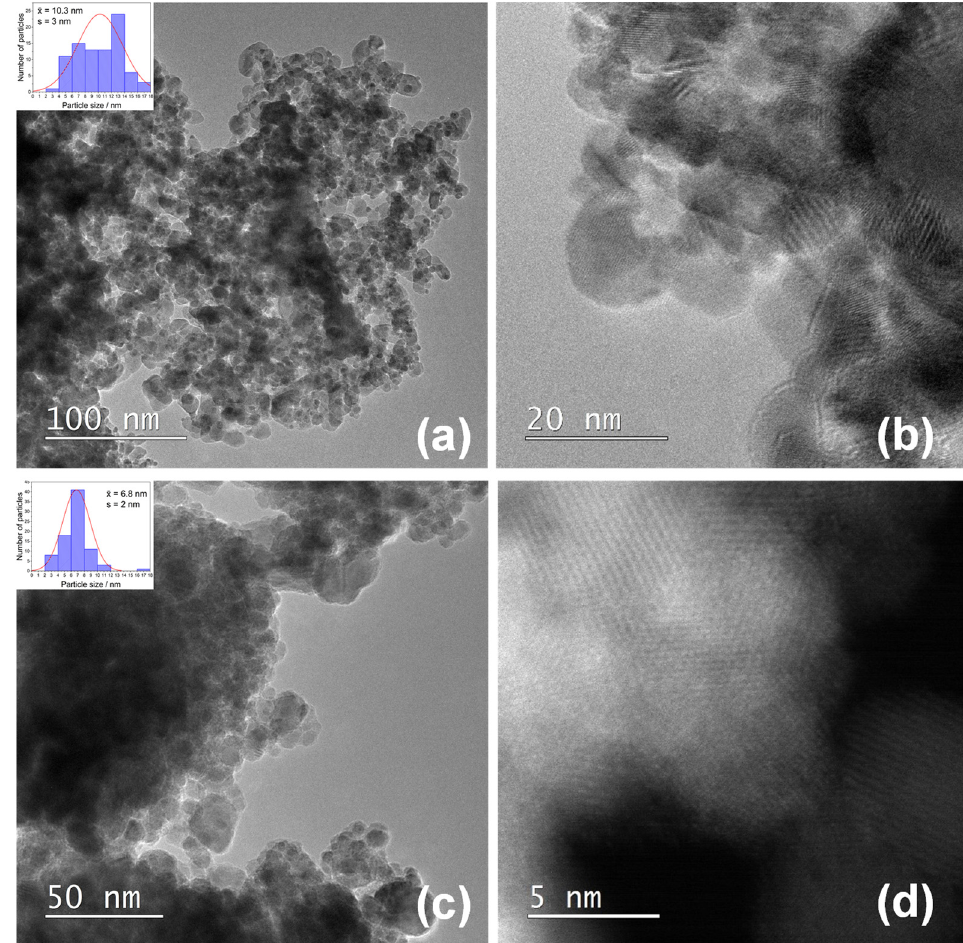
Key: M1 = Magnetic component fitted to Mössbauer sextet; δ = isomer shift given relative to α -Fe at 20 ◦ C; 2 ε = quadrupole shift; B